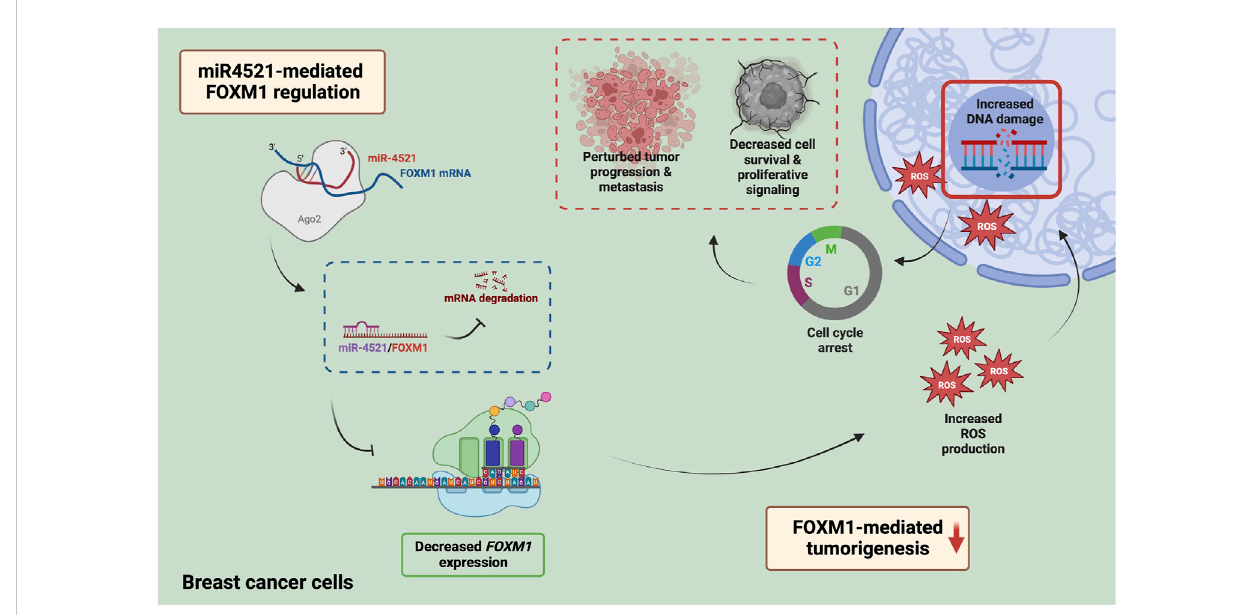
FIGURE 7 Mechanism of miR-4521 mediated inhibition of FOXM1 expression and perturb DNA damage response in breast cancer. Overexpression of miR- 4521 downregulates FOXM1 expression in breast cancer cells. This impairs antioxidant machinery of the breast cancer cells leading to increased DNA damage and reduced DNA damage response. This phenomena subsequently induces cell cycle arrest and impairs cell